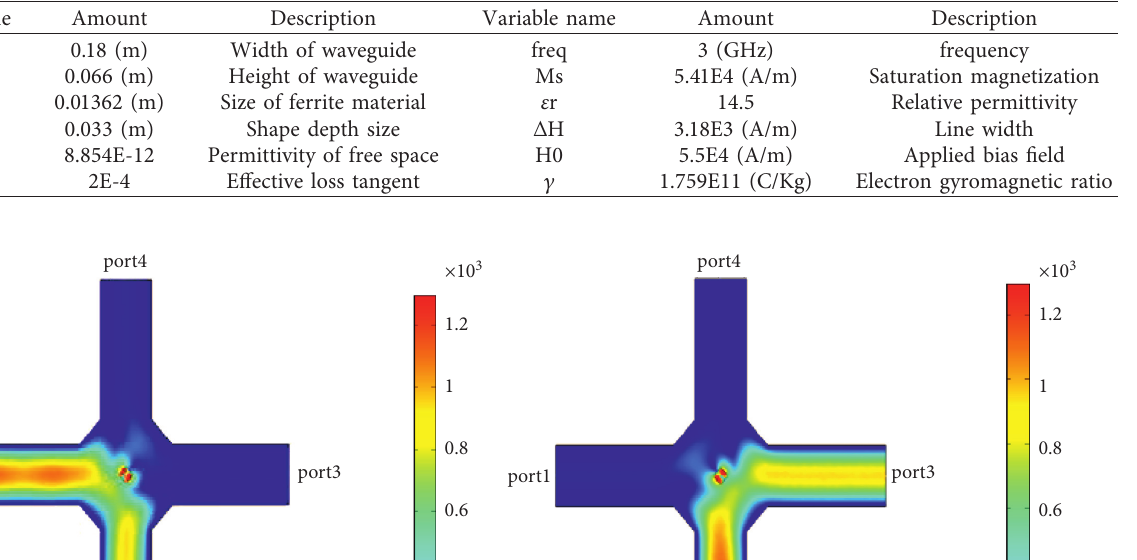
Table 1: Dimensions of geometry and characteristics of ferrite material.